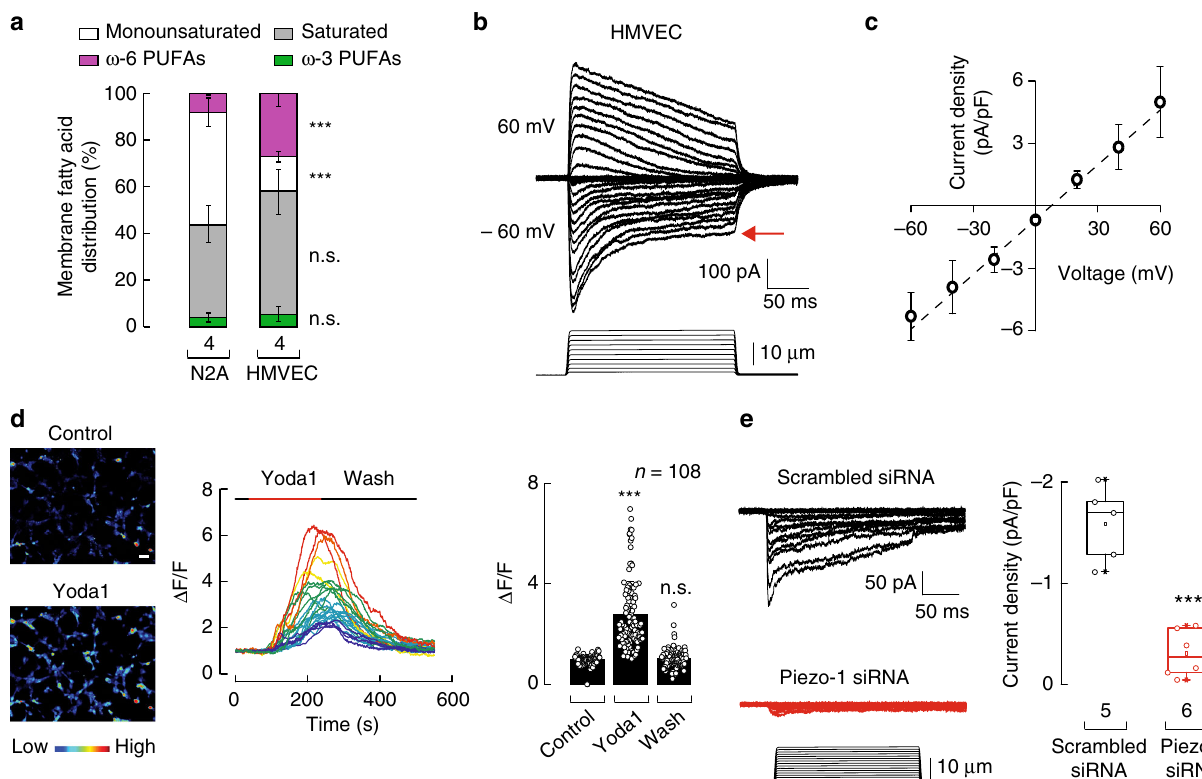
Fig. 4 Piezo1 channel mediates mechanically evoked currents in HMVEC. a Stacked bar chart illustrating the membrane fatty acid distribution in N2A cells and HMVEC, as determined by LC-MS. Bars are mean ± SD. n is denoted above the x -axis. Mann – Whitney test. b Representative whole-cell patch-clamp recordings (at ±60 mV) of HMVEC (top) elicited by mechanical stimulation (bottom). Red arrow highlights the steady-state currents. c Current – voltage relationship of HMVEC mechano-dependent currents as determined by whole-cell patch-clamp experiments. Circles are mean ± SD. n = 5. d Left: representative micrographs of HMVEC challenged with control buffer and 2 µ M Yoda1 and analyzed for their responses using Ca 2 + imaging (Fluo-4 AM); color bar indicates relative change in fl uorescence intensity. White bar represents 50 µ m. Middle: representative traces corresponding to intensity changes ( Δ F / F ) of individual cells shown in left panel. Right: mean fl uorescence intensity values ( Δ F / F ) of HMVEC perfused with control solution ( t = 30 s), Yoda1 ( t = 250s), and washed with control solution ( t = 500 s). Bars are mean ± SD. n is denoted above the plot. Friedman test. e Left: representative HMVEC mechano-dependent current densities transfected with scrambled or Piezo1 siRNA elicited by mechanical stimulation at − 60 mV under the whole-cell patch-clamp con fi guration. Right: boxplots show the mean, median, and the 75th to 25th percentiles of mechano-dependent currents densities obtained by whole-cell patch-clamp recordings of scrambled or Piezo1 siRNAs transfected HMVEC. n is denoted above the x -axis. Unpaired t -test. Asterisks indicate values signi fi cantly different from control ( ∗∗∗ p < 0.001) and n.s. indicates not signi fi cantly different from the